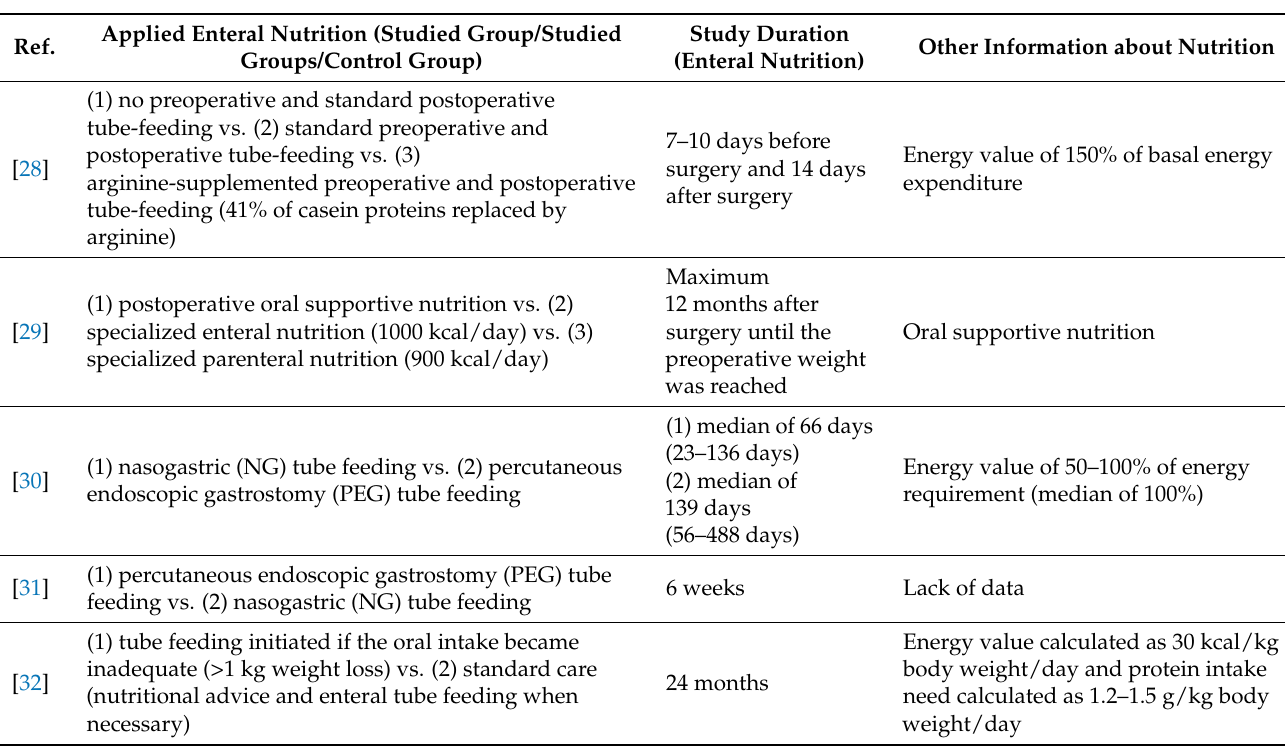
Table 6. The basic characteristics of the nutritional interventions associated with enteral nutrition applied within the studies included in the systematic